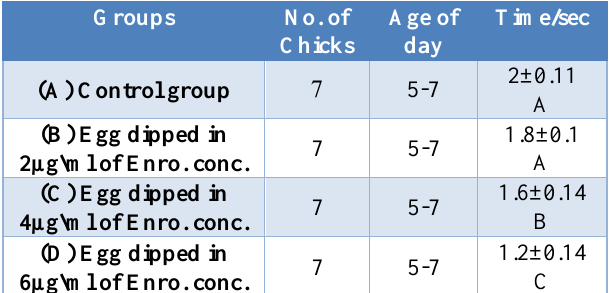
Table, 3: Tonic immobility test applied on newly hatched chicks whose eggs were dipped in different concentrations of Enrofloxacin. Groups No.